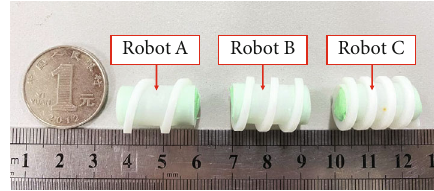
Figure 8: Capsule robots with di ff erent pitch.